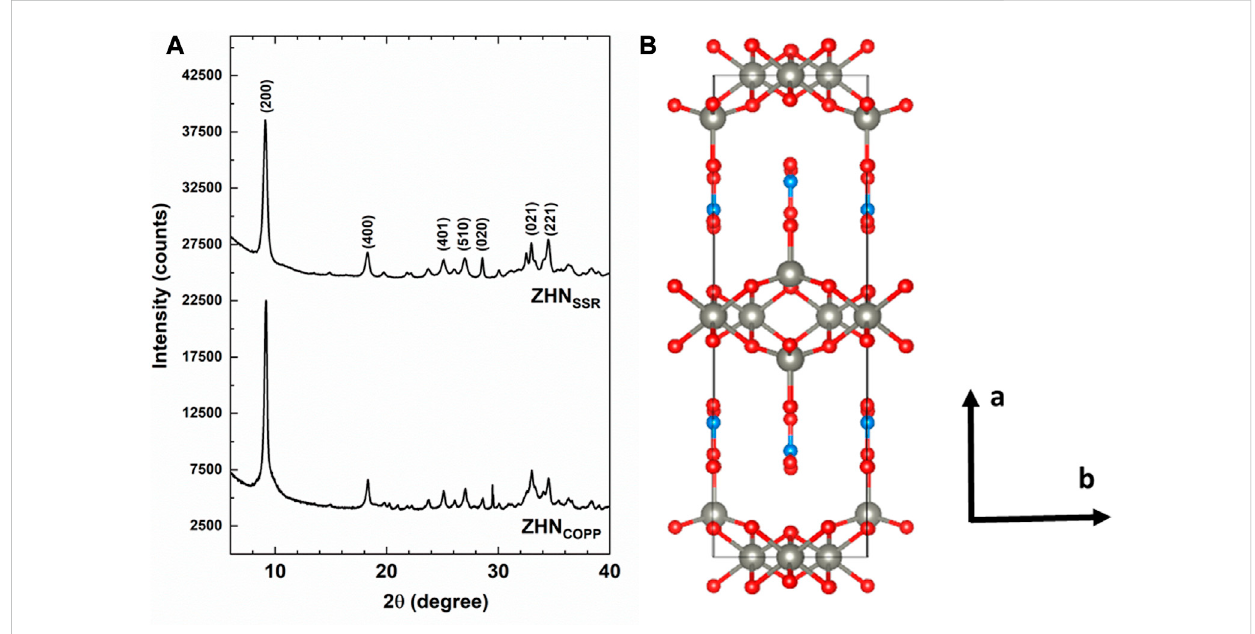
FIGURE 1 (A) XRD patterns of the as-prepared ZHN samples. Only the most intense peaks of the Zn 5 (OH) 8 (NO 3 ) 2 (H 2 O) 2 structure have been marked. (B) Structural model along the c-axis with the following color codes for atoms: grey – Zn, red – oxygen, light blue –